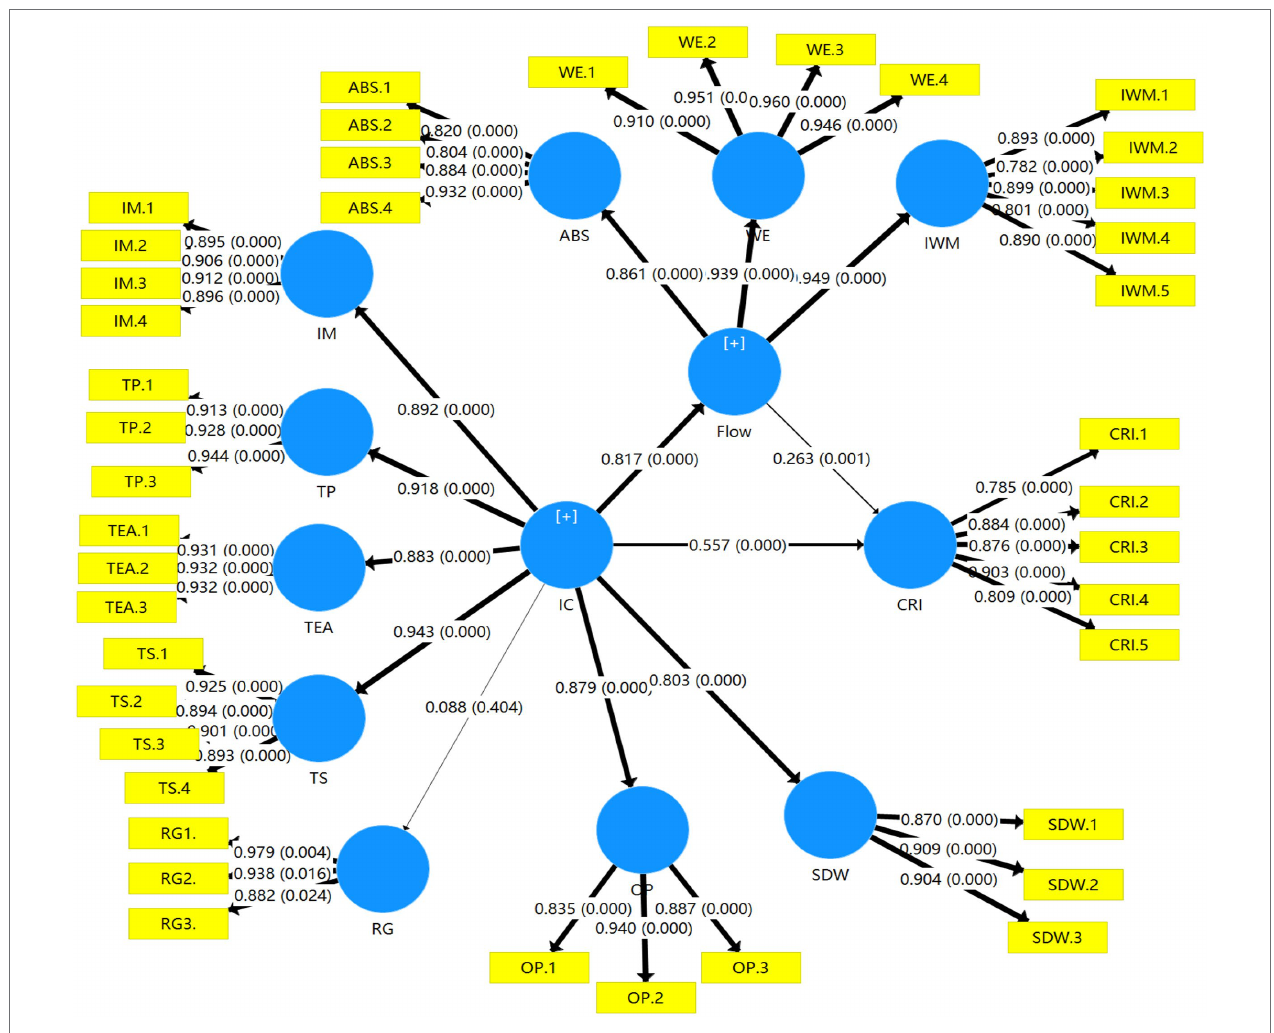
FIGURE 1 | The results of PLS analysis.